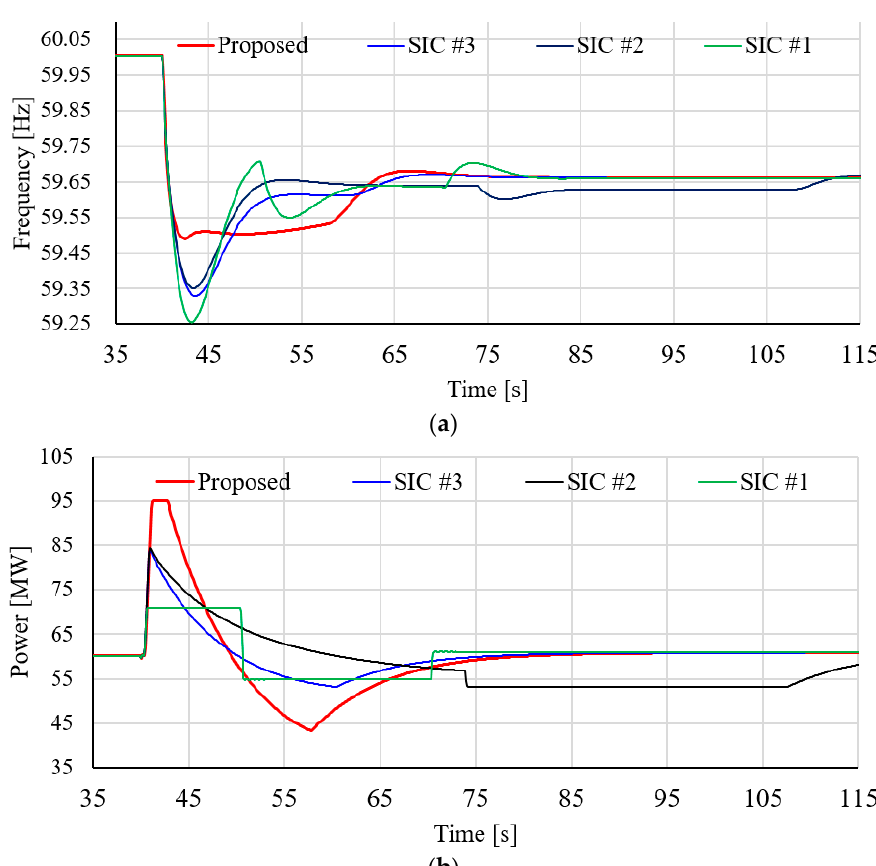
Figure 11. Results for Case 4. ( a ) System frequency; ( b ) Output power of the wind